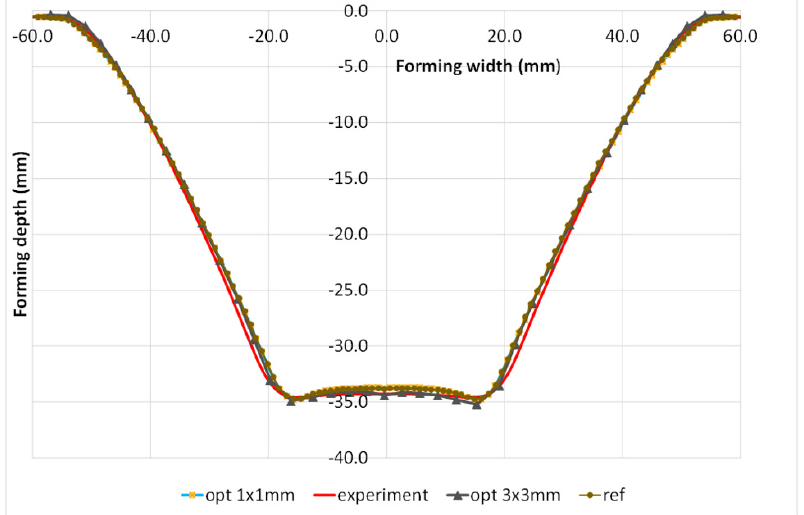
Figure 16. Comparison of experimental results with the FEM results of the DoE-selected parameters of mass scale, tool speed, and element size.